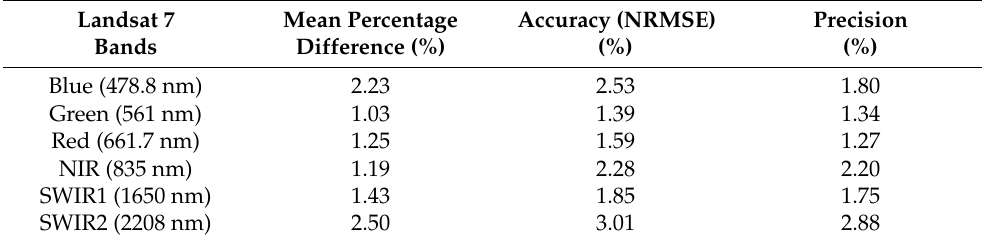
Table 6. Systematic offsets and random uncertainties between absolute calibration model predictions and Landsat 7